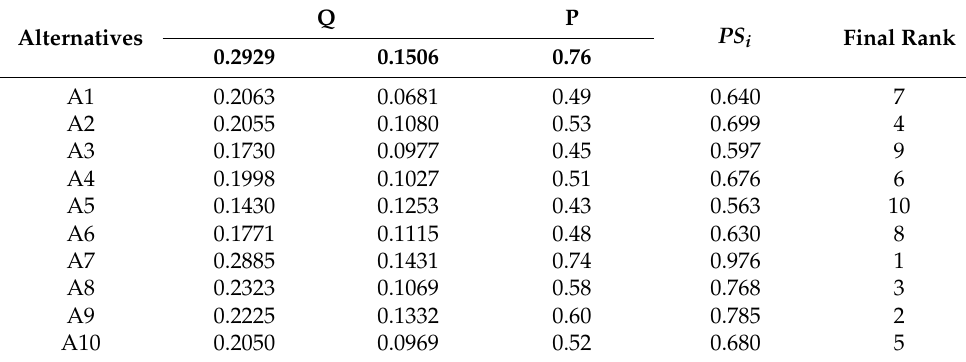
Table 8. Final ranks for alternatives using